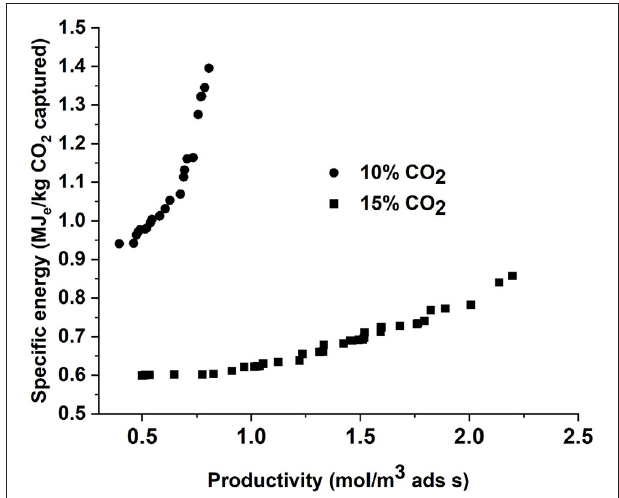
FIGURE 8 | Specific energy vs. Productivity Pareto fronts for 10 and 15% CO 2